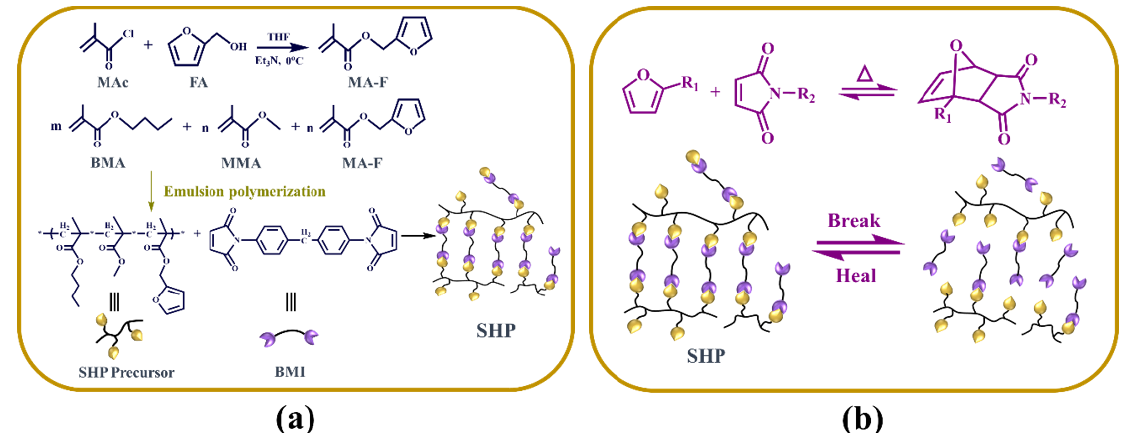
Figure 1. ( a ) Molecular structure design and synthesis of MMA-F, self-healing polymer (SHP) precursors and the SHP composite. ( b ) The mechanisms of the SHP composite based on the thermally reversible Diels-Alder (DA) reaction.